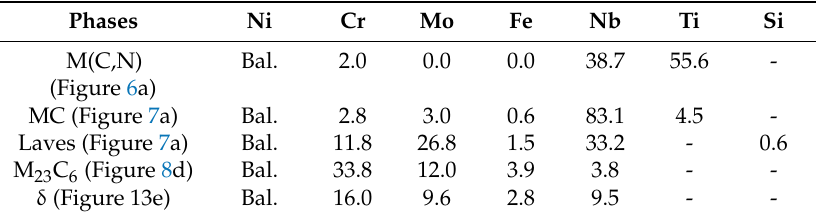
Figure 6. Backscatter-electron image (BEI) of a M(C,N) carbo nitride particle in plate hot rolled at 1050 °C with the deformation level of 4.6% (not aged) ( a ) and EDS spectrum of a M(C,N) carbo nitride ( b ).